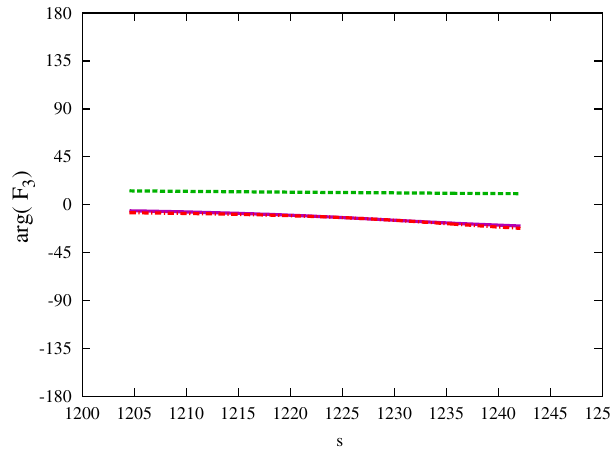
Þ at 205 GeV in the drift space j at 205 GeV in the drift space L232 FIG. 5. (Color) Graph of arg ð F FIG. 4. (Color) Graph of j F 3 3 L232 of RHIC for three scenarios: (a) solid (purple)—no rota- of RHIC for three scenarios: (a) solid (purple)—no rotators; tors; (b) dashed (green)—longitudinal polarization at both STAR (b) dashed (green)—longitudinal polarization at both STAR and and PHENIX; (c) dot-dashed (red)—no rotators at STAR, radial PHENIX; (c) dot-dashed (red)—no rotators at STAR, radial polarization at PHENIX. The horizontal axis shows the arclength polarization at PHENIX. The horizontal axis shows the arclength in meters, measured from the 6 o’clock point. in meters, measured from the 6 o’clock